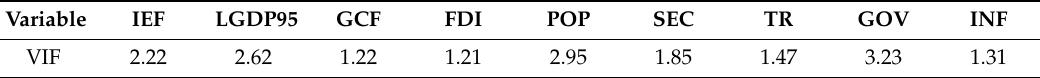
Table 2. Multicollinearity test (variance inflation factor (VIF) values).